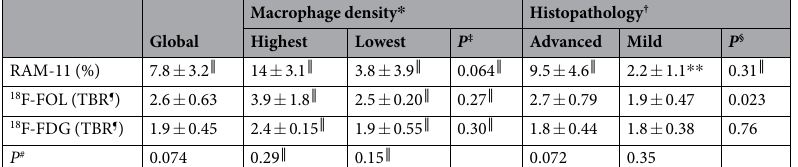
Macrophage density * Histopathology † Global Highest Lowest P ‡ Advanced Mild P § RAM-11 (%)